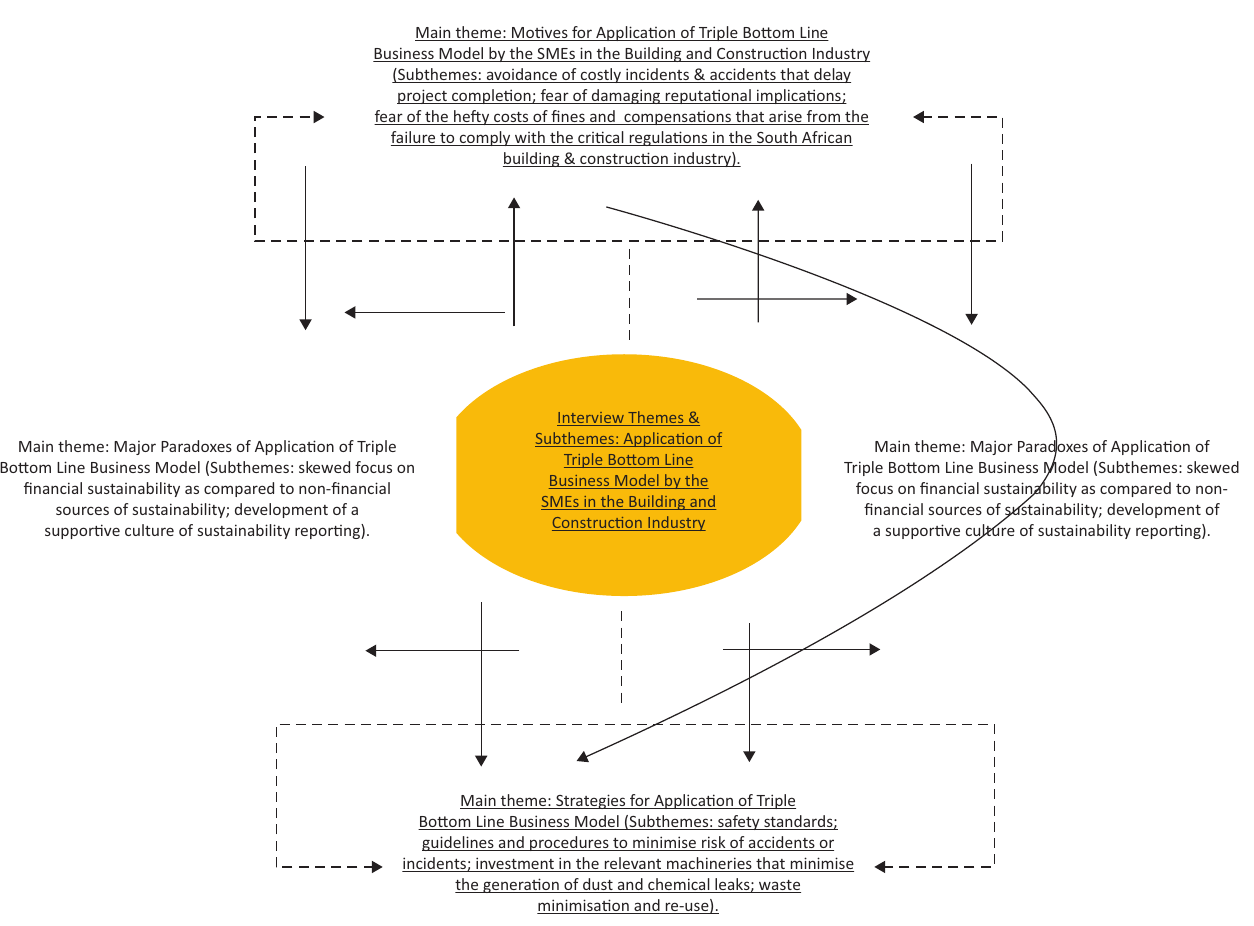
FIGURE 1: Interview themes: Application of triple bottom line business model by small and medium-sized enterprises in the building and construction